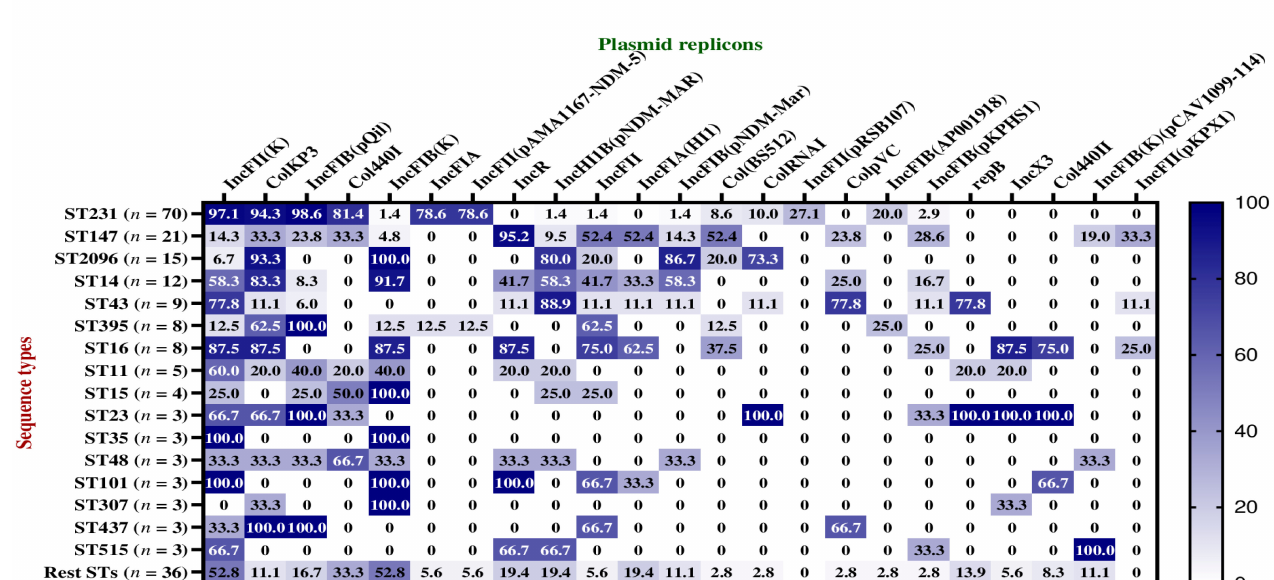
Figure 5. Heatmap of percentage distribution of plasmid replicons among STs. ( n ) Indicates the total number of particular STs. On the scale, dark blue indicates 100%, white indicates 0%. The GraphPad Prism 8.4.2 tool was used to generate this